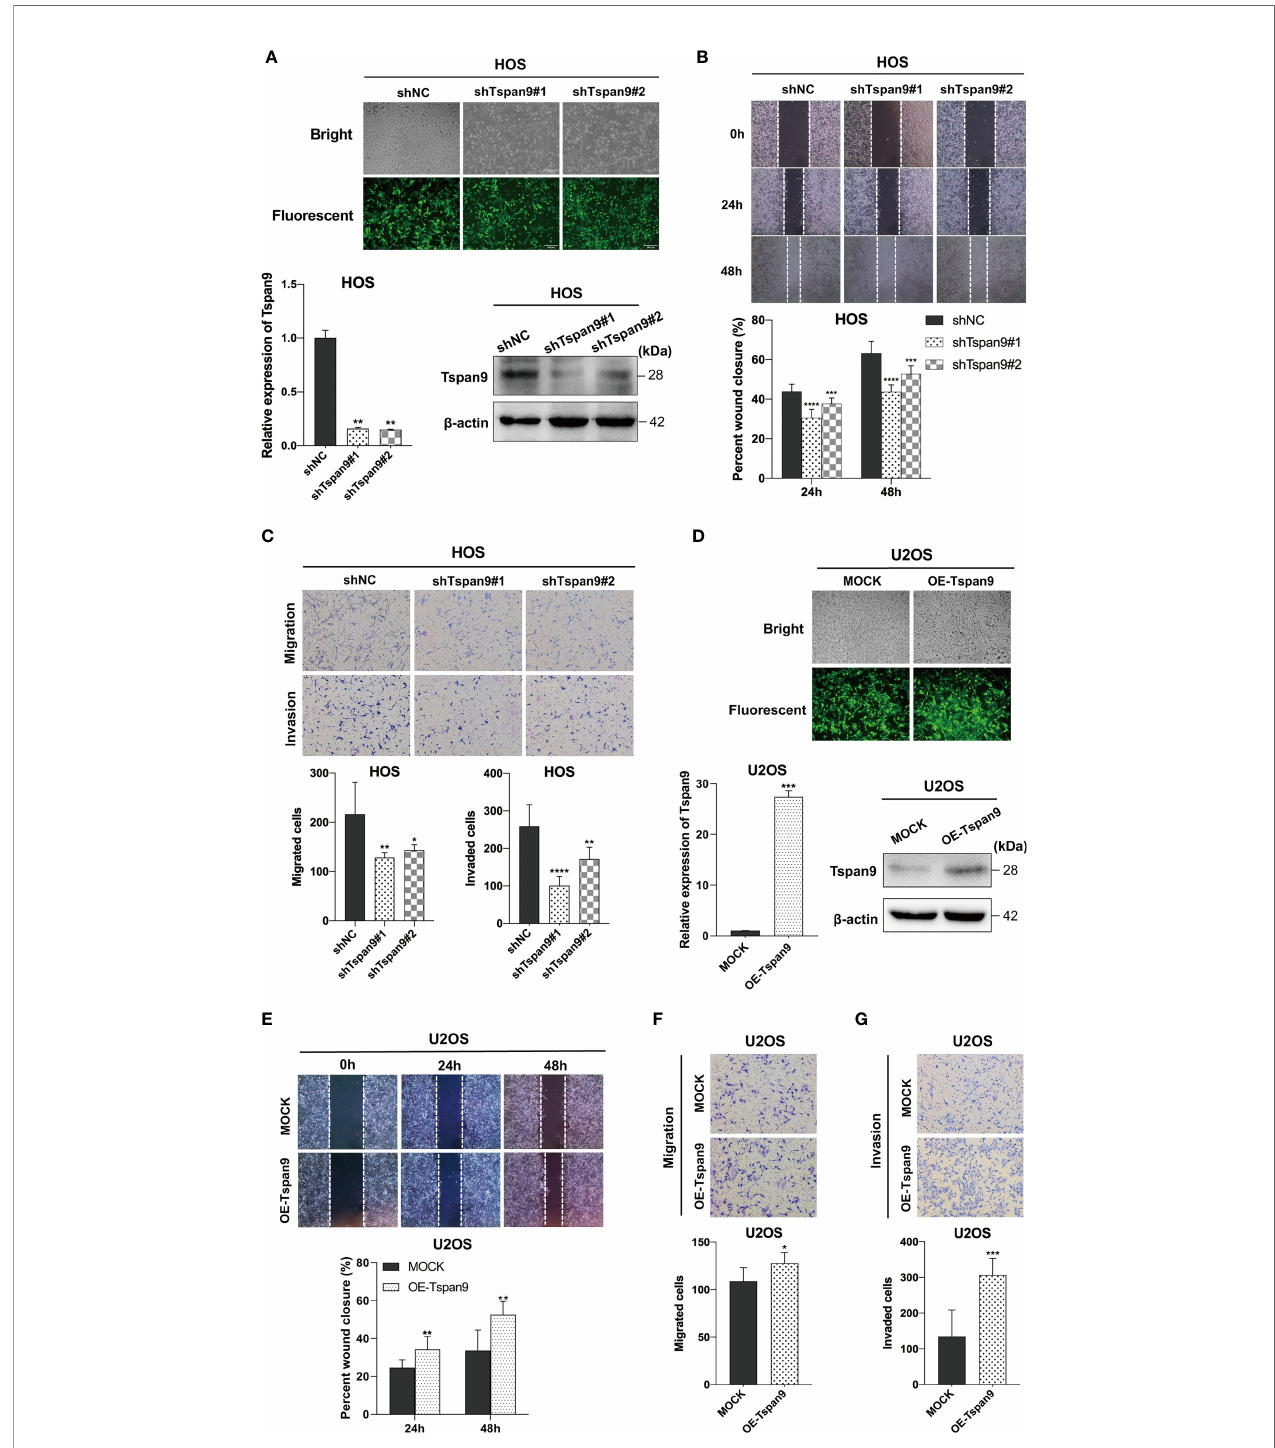
FIGURE 4 | Tspan9 promotes in vitro OS cell migration and invasion. (A) GFP expression was indicative of stable lentiviral transduction of HOS cells with shTspan9 (shTspan9#1 or shTspan9#2) or shNC constructs at near 100% ef fi ciency ( fl uorescent microscopy). Tspan9 knockdown ef fi ciency was also con fi rmed via qRT-PCR (lower left panel) and Western blotting (lower right panel). (B) OS cell migration was assessed in a wound-healing assay using cells stably expressing shTspan9 or shNC. (C) The impact of Tspan9 knockdown on OS cell migration and invasion was assessed via a Transwell approach. (D) GFP expression was indicative of successful Tspan9 overexpression, as con fi rmed via qRT-PCR and Western blotting relative to Mock control. Wound-healing (E) and Transwell assays (F, G) were conducted to assess the impact of Tspan9 on the migratory and invasive activity of OS cells. * P < 0.05; ** P < 0.01; *** P < 0.001; **** P < 0.0001; Student ’ s t-test. GFP, green fl uorescent protein; sh, short hairpin